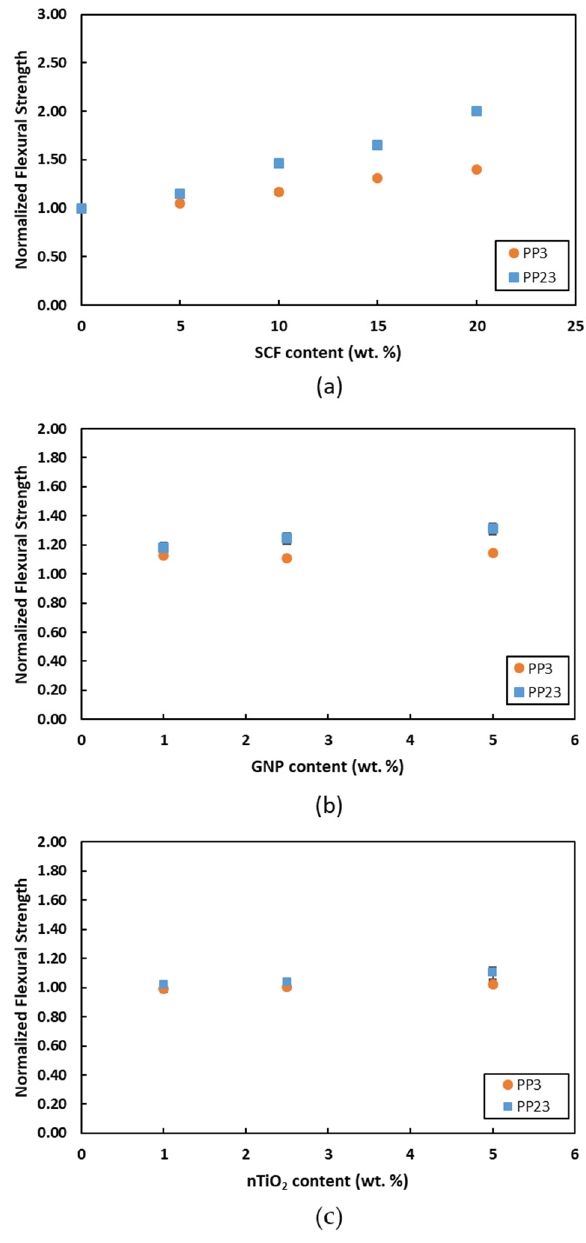
Figure 14. Normalized flexural strength of ( a ) PP/SCF, ( b ) PP/GNP, and ( c ) PP/nTiO 2 composites.